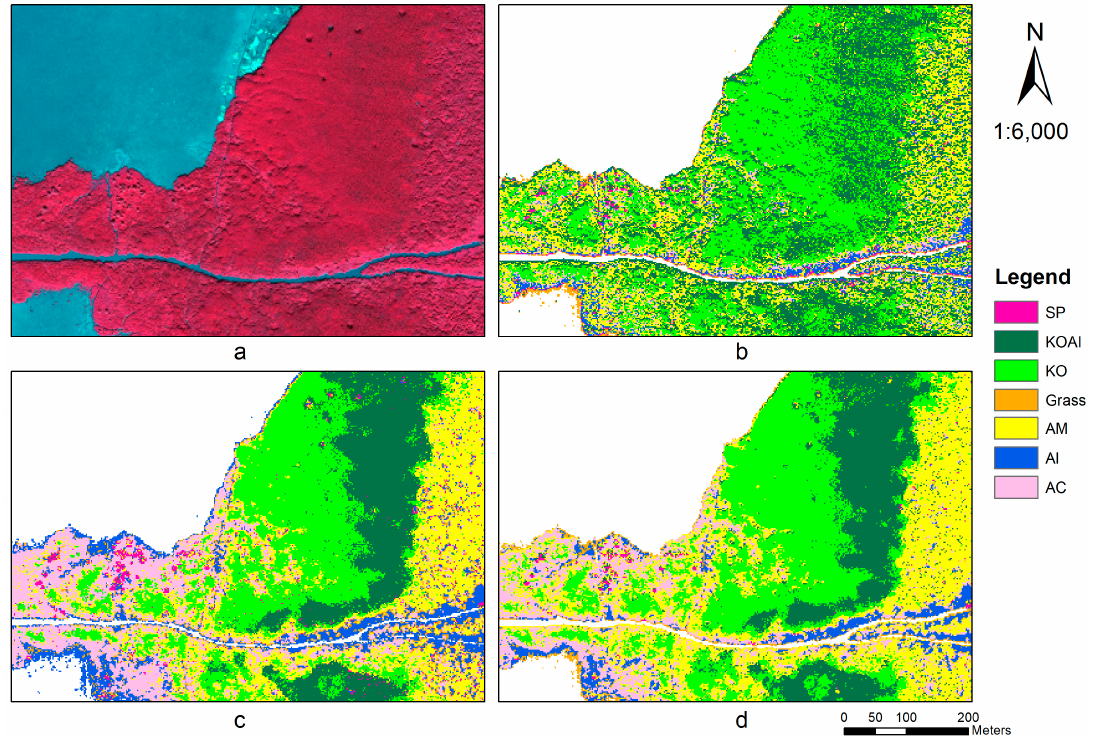
Figure 6. ( a ) WV-3 multispectral image and classification image, ( b ) RF classification based on WV3 images, ( c ) RF classification based on LiDAR metrics, ( d ) RF classification based on Combined WV3 and LiDAR.